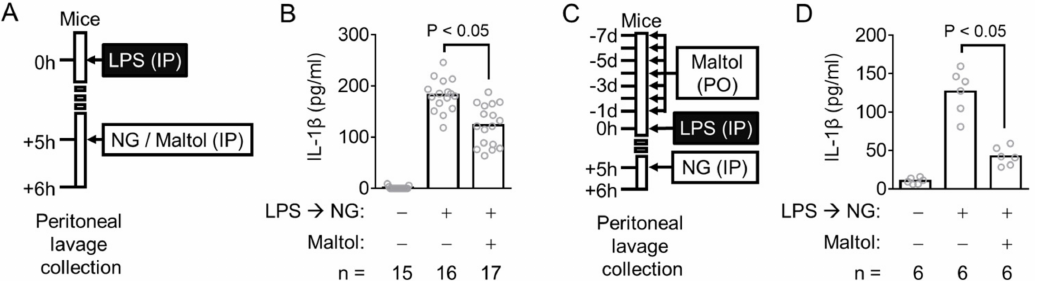
Figure 3. Effect of maltol on the inflammasome activation in mice. ( A ), Schematic diagram describes the mode of the maltol injecting experiment. ( B ), The peritoneal IL-1 β production of the mice treated similar to panel A was measured. ( C ), The procedure for oral maltol administration is shown. ( D ), The secretion of peritoneal IL-1 β of the maltol-fed animals was analyzed. IL-1 β releases were measured by ELISA. The bar graph presents the mean, and each gray circle indicates a value from each mouse. Next, the role of maltol on ROS production, which has been reported as a common signaling for NLRP3 inflammasome activation, was elucidated [30]. Rotenone, which in- creases ROS generation through mitochondria dysregulation, acts as a selective NLRP3 trigger [2,30]. LPS-primed BMDMs were treated with rotenone, leading to IL-1 β